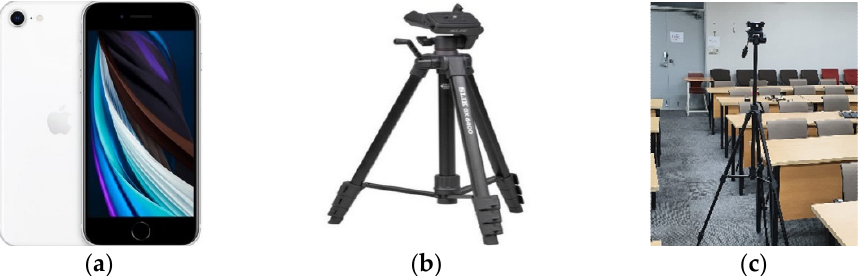
Figure 3. Data Collection Environment (Indoor Experiment): ( a ) Smartphone (iPhone SE2), ( b ) Tri- pod (ZF-400), ( c ) Experimental Device.